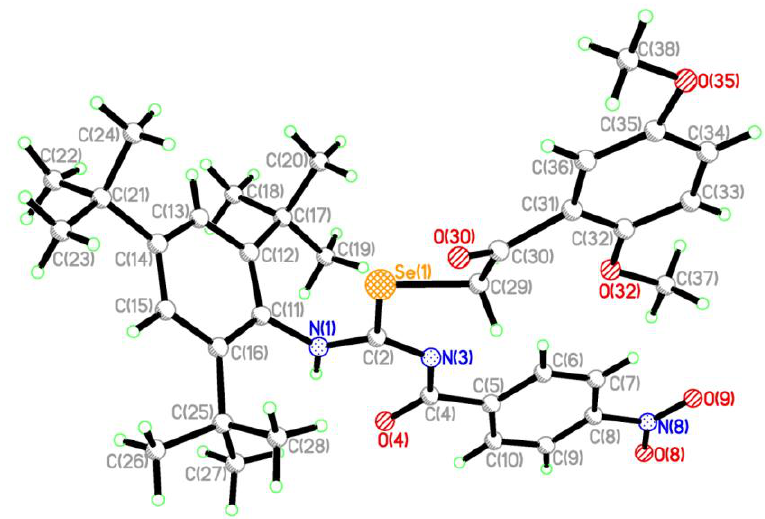
Figure 5. Single crystal X-ray structure of compound 4 . N(1)-C(2) 1.326(5)[1.319(5), 1.328(5)], C(2)-